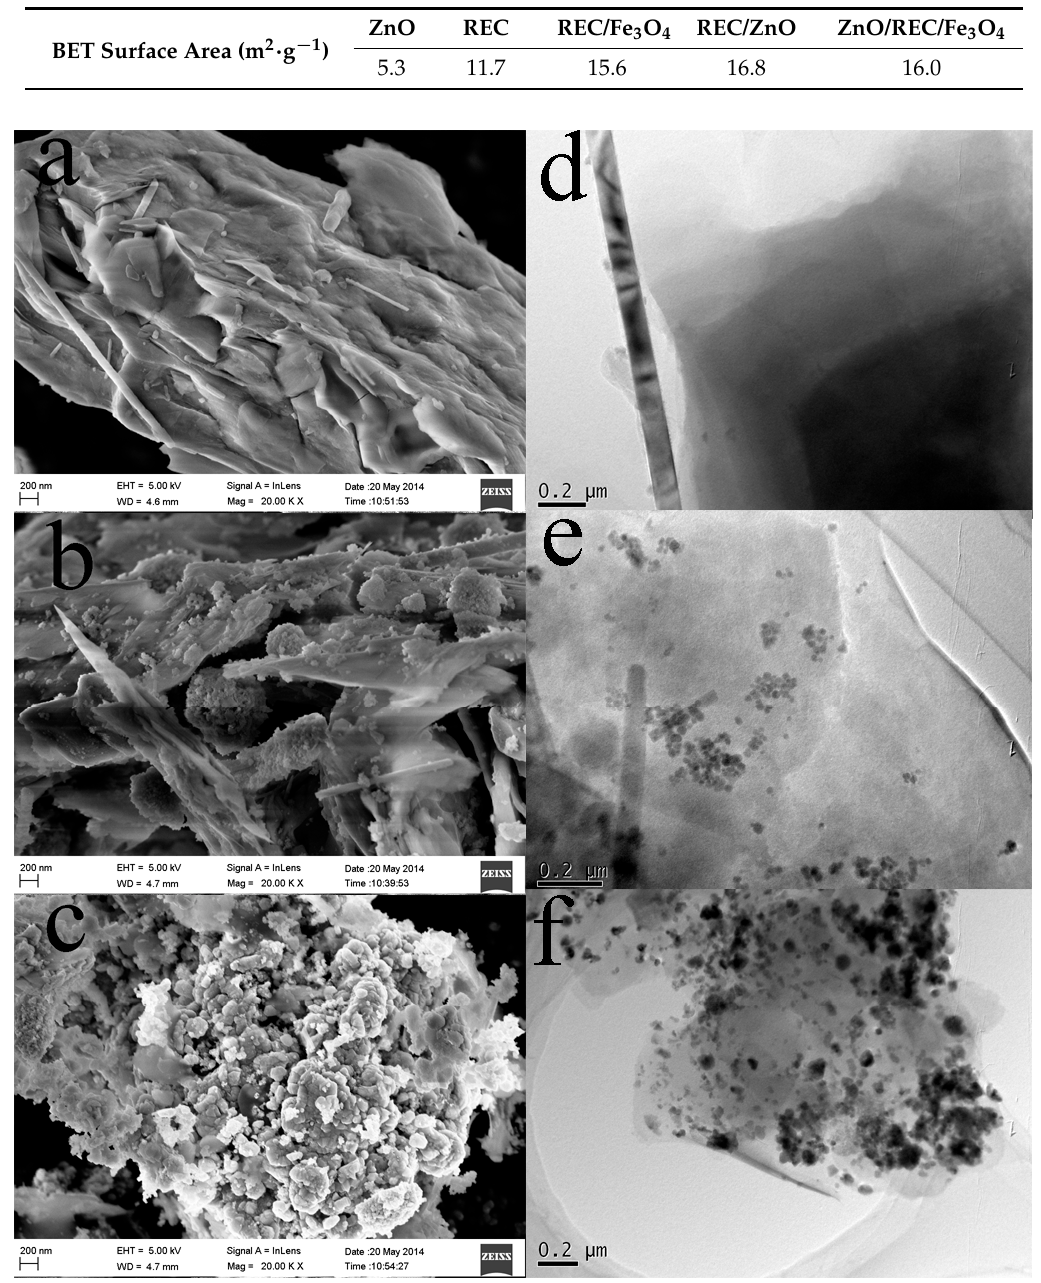
Figure 1. Scanning electron microscopy (SEM) images of ( a ) rectorite (REC), ( b ) REC/magnetite (Fe 3 O 4 ) (1:0.3), and ( c ) REC/Fe 3 O 4 /zinc oxide (ZnO) (1:0.3:0.5) and transmission electron microscopy (TEM) images of ( d ) REC, ( e ) REC/Fe 3 O 4 (1:0.3), and ( f ) REC/Fe 3 O 4 /ZnO (1:0.3:0.5).